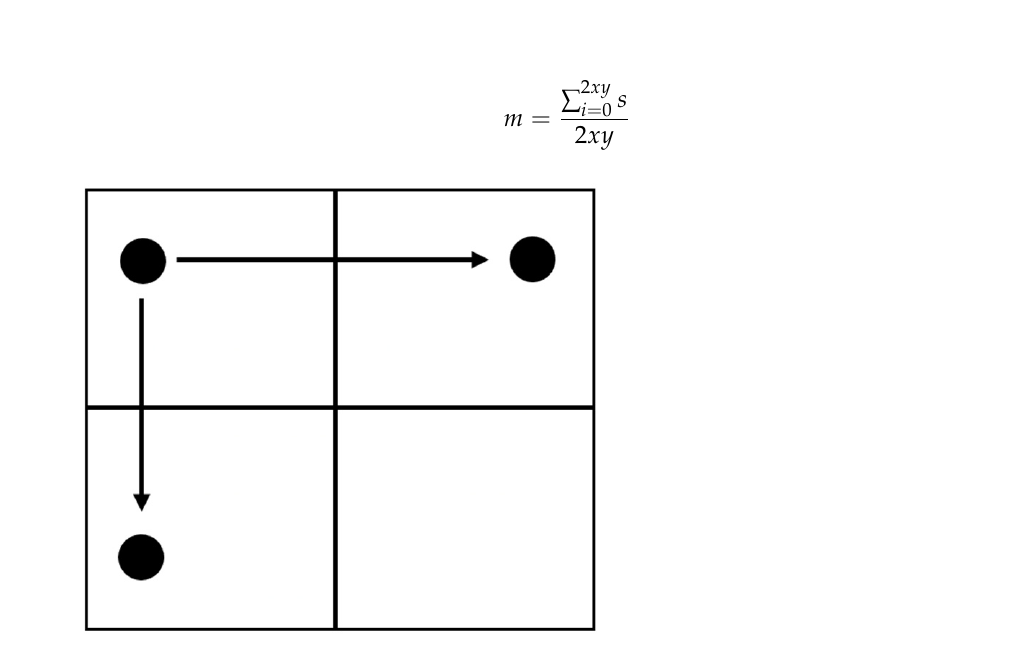
Figure 3. Symmetry calculation for single grid axis.